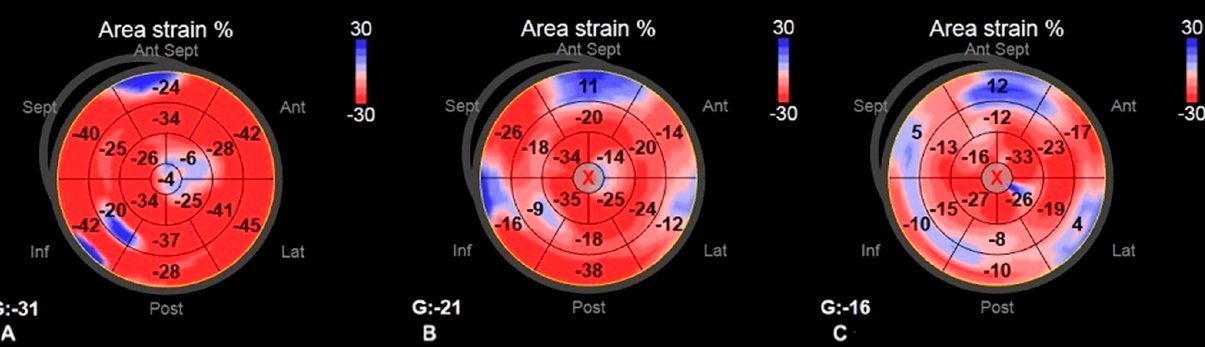
Figure 3. The example of 2D LV global longitudinal strain measurements—the bull eye representation of a healthy person ( A ); HCM patient without FA diagnosis ( B ); HCM patient with FA diagnosis ( C ).